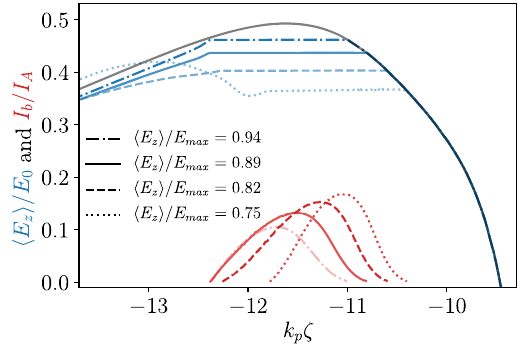
=I FIG. 3. Current profiles for an optimally loaded wake I b A (red), and corresponding lineouts of the transversally averaged i =E accelerating field, h E 0 (blue). The current profiles and their z corresponding accelerating gradient is given for four values of the ζ ¼ − 11 . 0 (dotted dashed), witness bunch head position, k p head − 10 . 8 (solid), − 10 . 6 (dashed), − 10 . 4 (dotted). Their relative averaged accelerating gradients within the beam are (in the same order as the starting position) 0.462,0.438,0.403,0.367 with respect to the maximum averaged accelerating gradient of the i =E ¼ 0 . 49 . The same line style marks the unloaded wake h E 0 max current profile and its corresponding field lineout. The presented current profiles optimally load the wake, resulting in a flattened h E i =E 0 . z